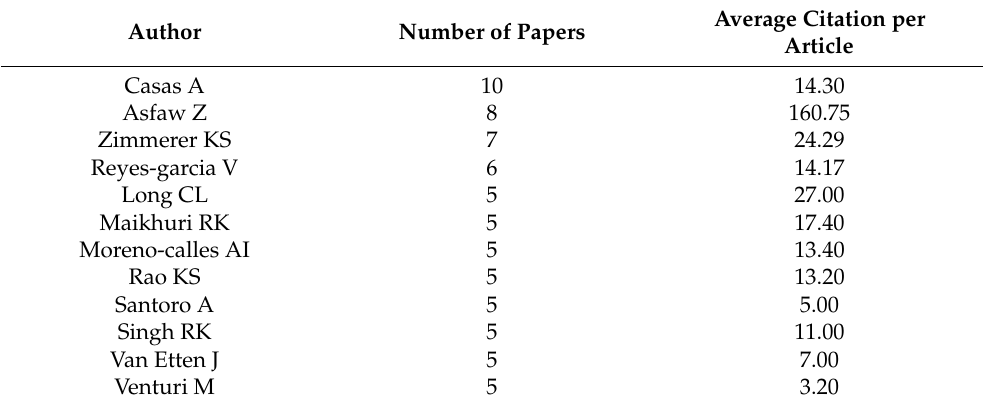
Table 3. Top 12 authors in a number of publications.